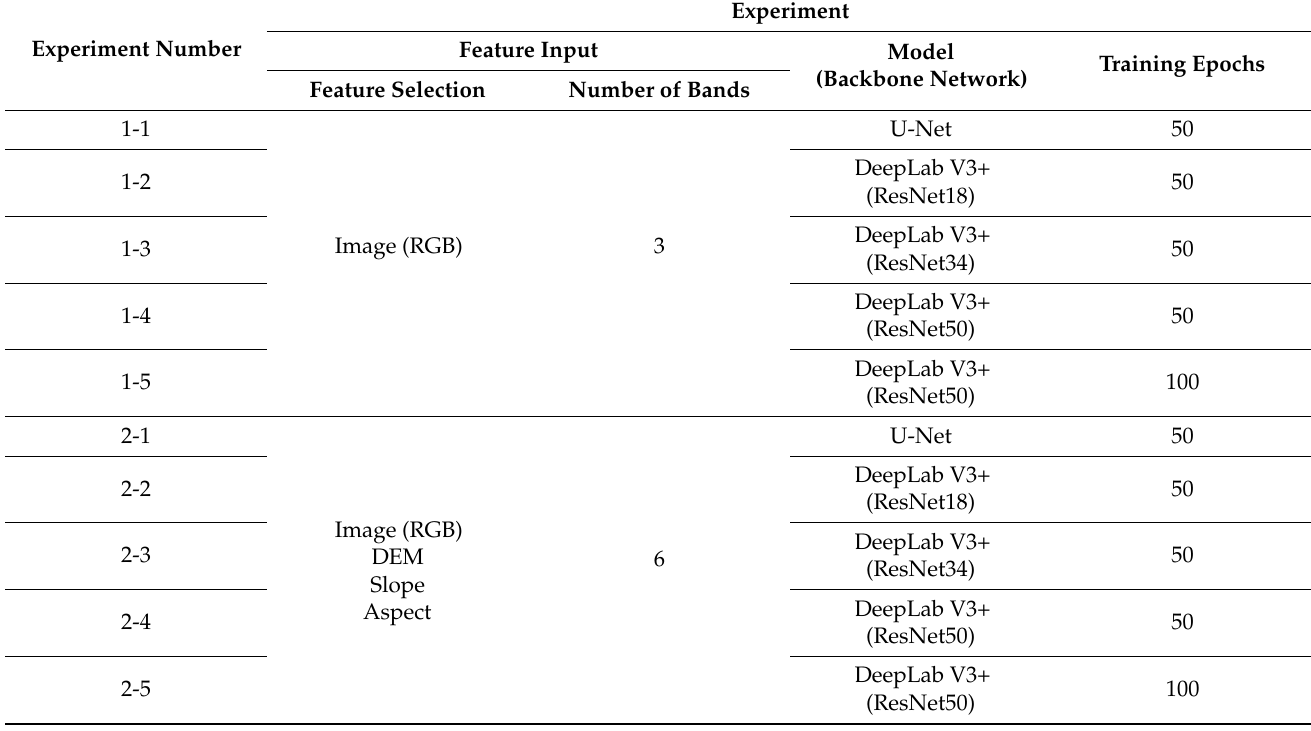
Table 3. List of experiments carried out in the study.